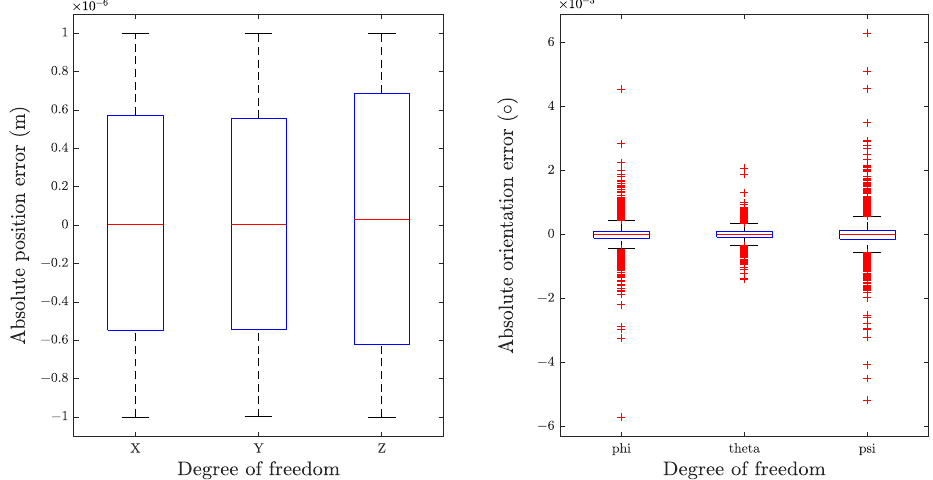
Figure 6. Absolute errors distribution of initial solutions in each direction.